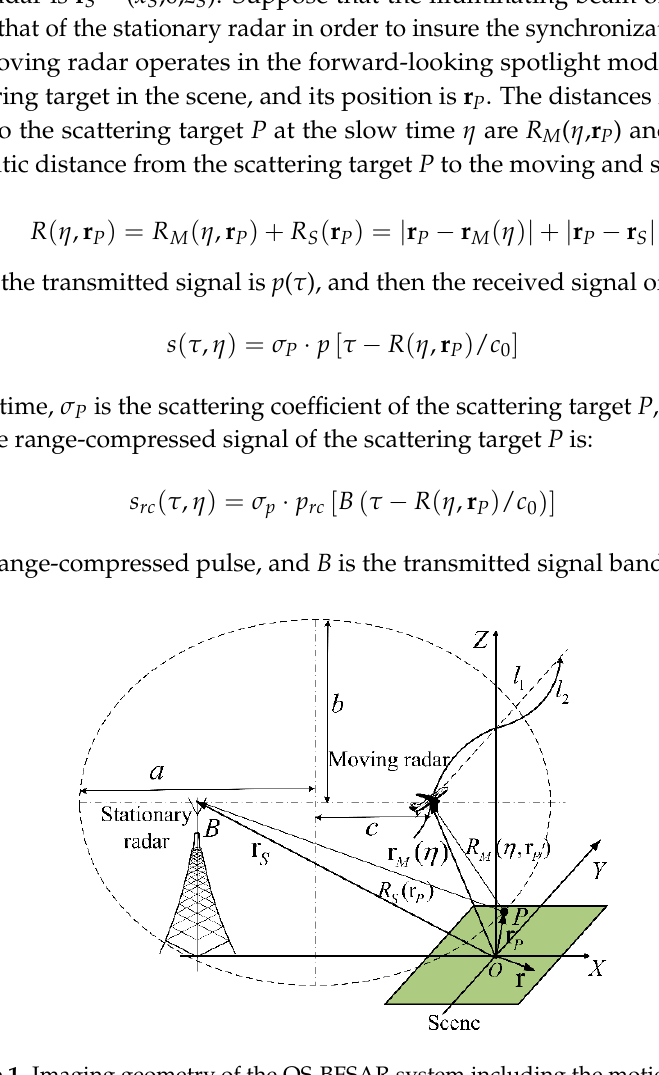
Figure 1. Imaging geometry of the OS-BFSAR system including the motion errors.